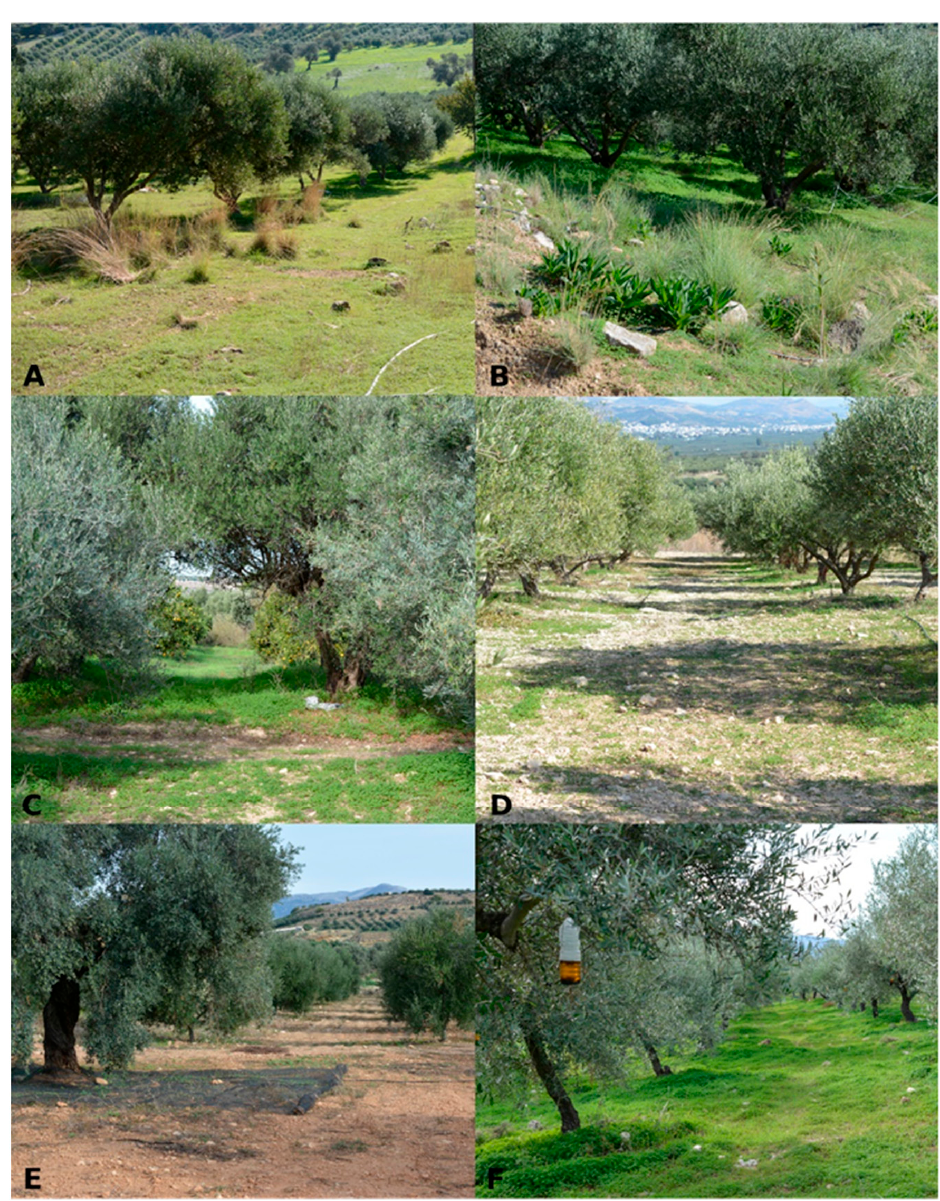
Figure 2. Photos of some of the olive orchards under investigation (numbering follows Table 1). ( A ) olive orchard 2o. ( B ) olive orchard 3o. ( C ) olive orchard 5o. ( D ) olive orchard 5c. ( E ) olive orchard 11c. ( F ) olive orchard 11o.